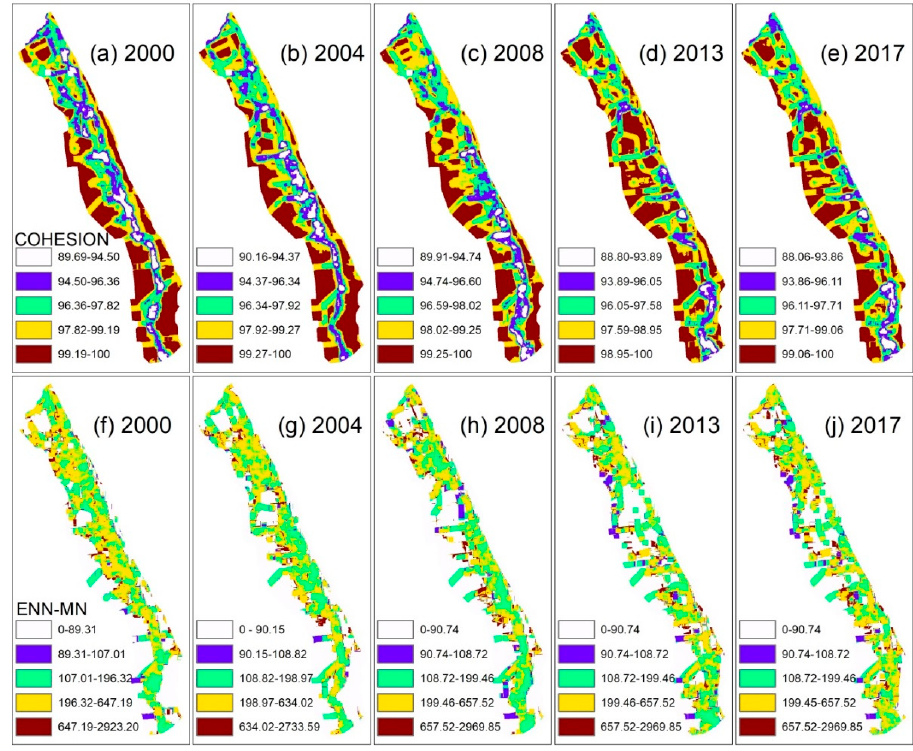
Figure 6. ( a – e ) Comparison of the landscape heterogeneity of COHESION during five intervals from 2000–2017. The degree of mosaicism of the landscape pattern is represented by the degree of COHESION. The greater the COHESION value, the higher the degree of patch connectivity of the landscape and the lower the degree of spatial mosaic; ( f – j ) Comparison of the landscape heterogeneity of ENN–MN during five intervals from 2000–2017. Distance analysis of the landscape is expressed by ENN–MN. The larger the value of ENN–MN, the greater the distance between the landscapes type blocks and the more scattered the distribution.